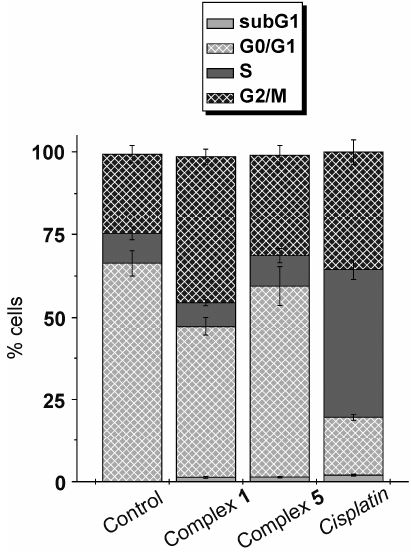
Figure 4. Populations in cell cycle phases studied against the A2780 human ovarian carcinoma cells treated with the complexes 1 and 5 , and cisplatin for comparative purposes (control = non-treated cells). Cells were stained with propidium iodide (PI)/RNase. The data are given as the arithmetic mean ± SD from three independent experiments carried out on cells from three consecutive passages.